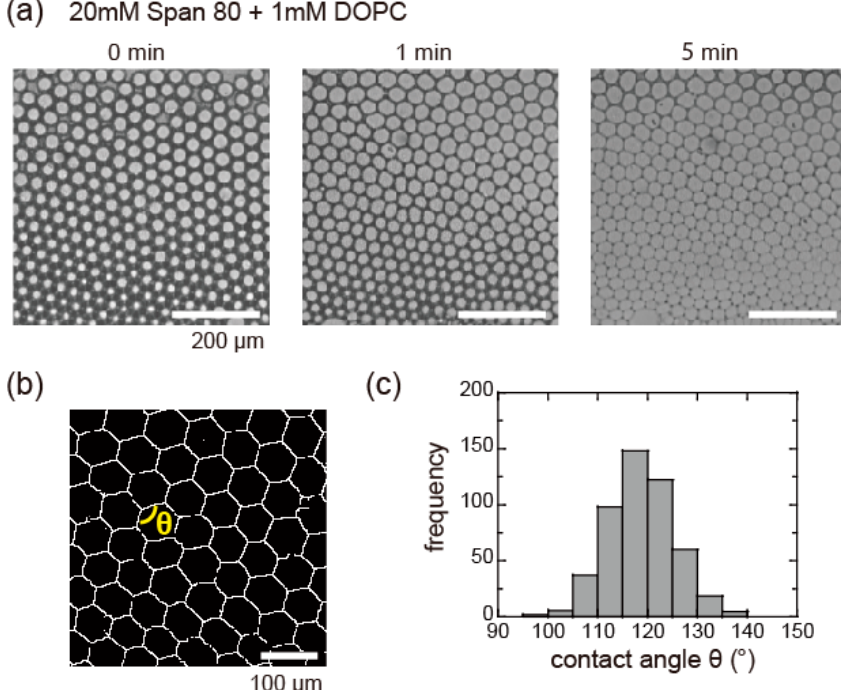
Figure 5. ( a ) Bright field images show the time evolution of hexagonal honeycomb-patterned droplets with DIBs from isolated droplets covered with monolayer of 1mM PC and 20 mM Span 80. Scale bar is 200 µ m. ( b ) Binary image of honeycomb-patterned droplets. Scale bar is 100 µ m. ( c ) Histogram of contact angle θ (119 ± 7, n = 497) derived from binary images of honeycomb-patterned droplets.